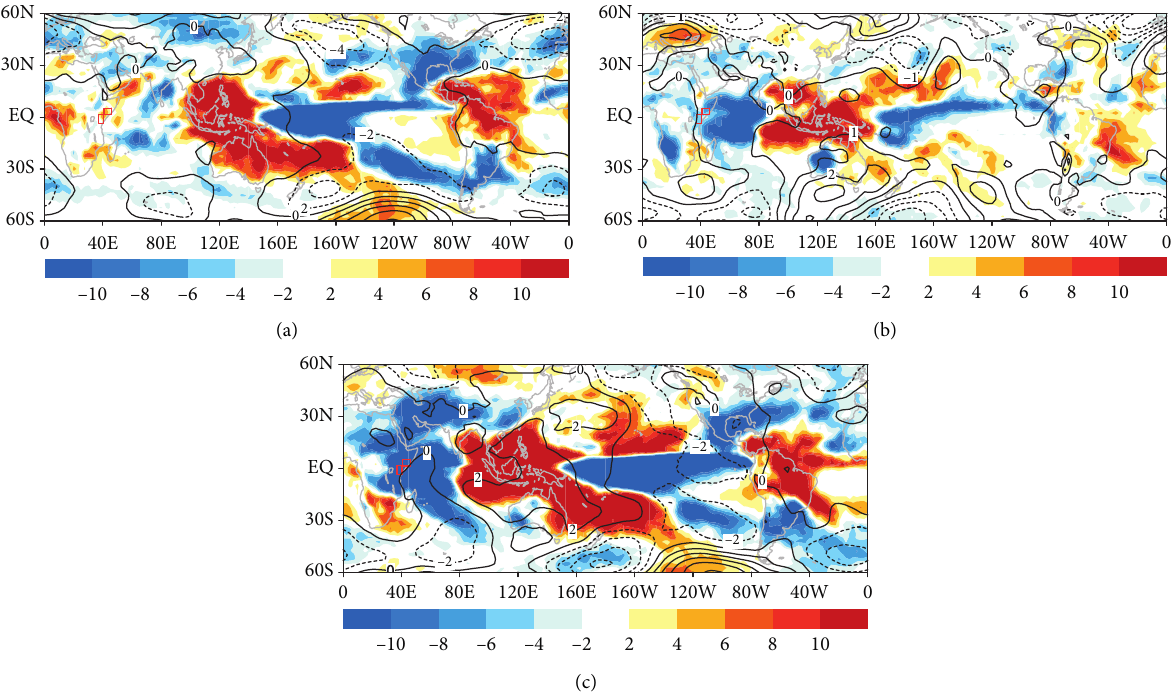
Figure 15: Same as Figure 14, but for OND season. (a) OND OLR and SLP (ENSO alone), (b) OND OLR and SLP (IOD alone), and (c) OND OLR and SLP (both ENSO &